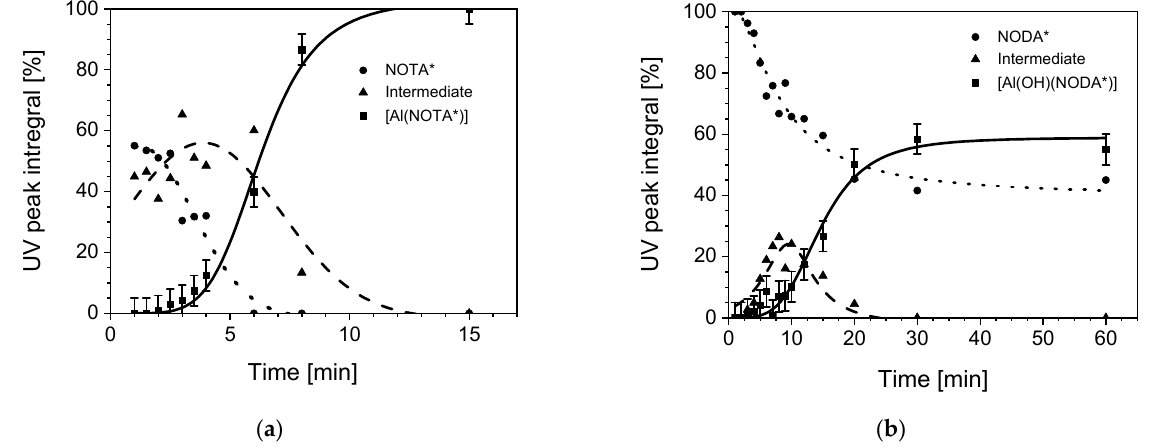
Figure 3. ( a ) Formation of the [Al(NOTA*)] complex over a time span of 15 min determined by HPLC measurements. Reaction conditions: 1.23-fold Al 3+ ion excess compared to chelator, NOTA* concentration of 1.84 mM, 55 mM of NH 4 OAc- buffer pH 4.1, reaction temperature of 100 °C. Aqueous reaction medium. UV detection at 254 nm. Retention times were 2.2, 2.9, and 5.7 for the species: [Al(NOTA*)], intermediate and NOTA* (precursor), respectively ( b ) Formation of [Al(OH)(NODA*)] complex over a time span of 60 min determined by HPLC measurements. Reaction parameters and detection were analogous to the reaction with the NOTA* chelator. Only buffer concentration was higher: 91 mM. Retention times were 5.4, 6.0, and 6.9 for the species: intermediate, [Al(OH)(NODA*)], and NODA* (precursor), respectively. For better legibility in both plots, error bars ( ± 5%) are only shown for the product